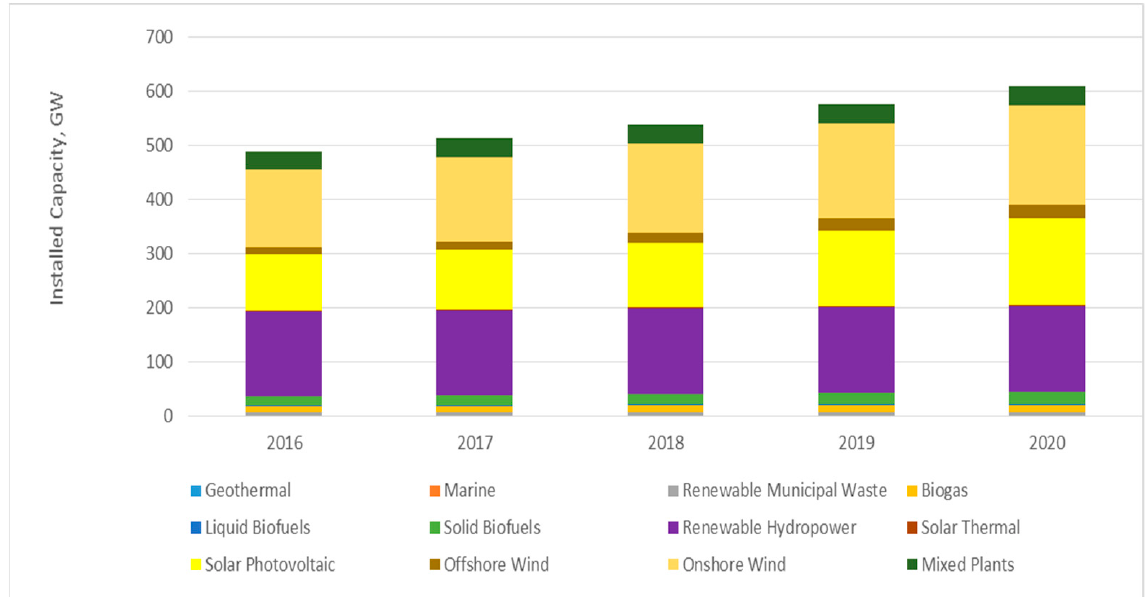
Figure 2. Dynamics and structure of growth of the installed capacity of technologies based on renewable energy sources in Europe in 2016–2020 (IRENA).